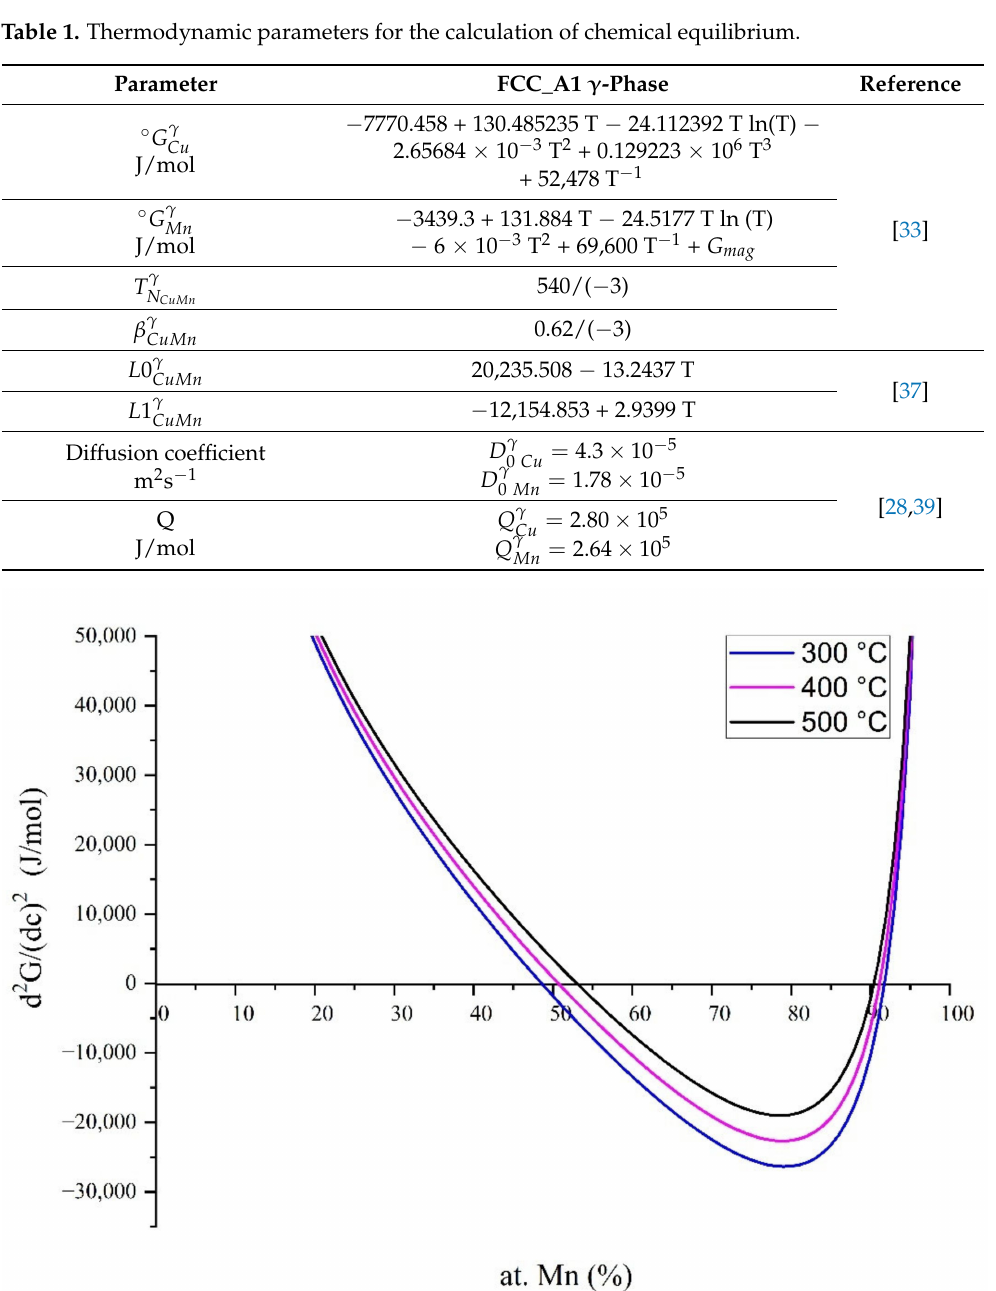
Figure 2. Calculated second-order partial derivative of free energy at 300 ◦ C, 400 ◦ C, and 500 ◦ C corresponding to Figure